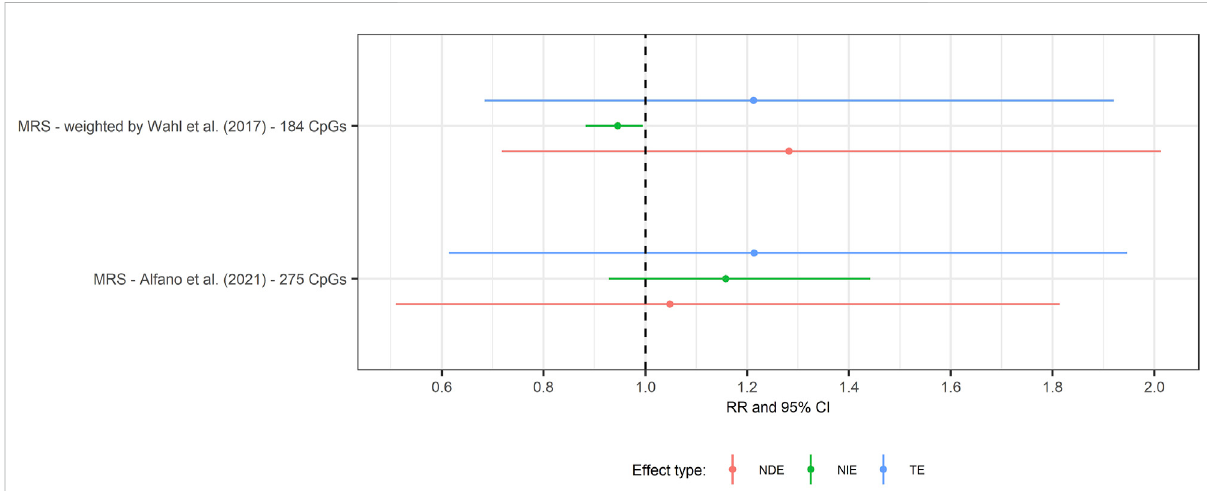
FIGURE 7 Forest plot of the mediation analysis by methylation risk scores at age 7 years of obesity at 7 years and SMFQ score at 11 years, follow-up. Rate ratioand95%CI(bars) for naturaldirecteffect (redline),naturalindirecteffect(green line)andtotaleffect(blue line)fromsingle mediation analysis of obesity at 7 years on SMFQ through MRS. Rate ratio refers to MRS 1) based on Wahl et al. (2017) study (Supporting Information S1, Supplementary Table S1) and 2) based on 275 CpGs associated with child adiposity (Alfano et al., 2021) (Supporting Information S1, Supplementary Table S2).